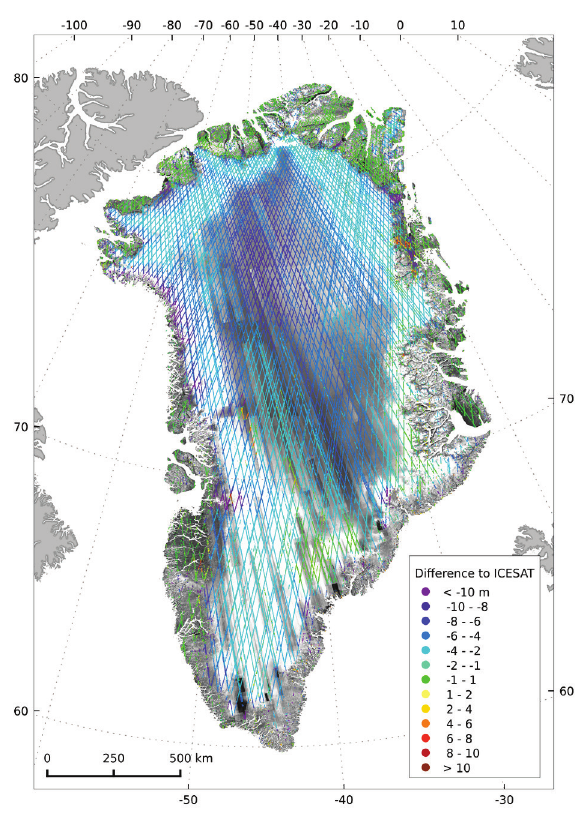
Figure 6. Amplitude mosaic superimposed with color-coded height differences TanDEM-X –